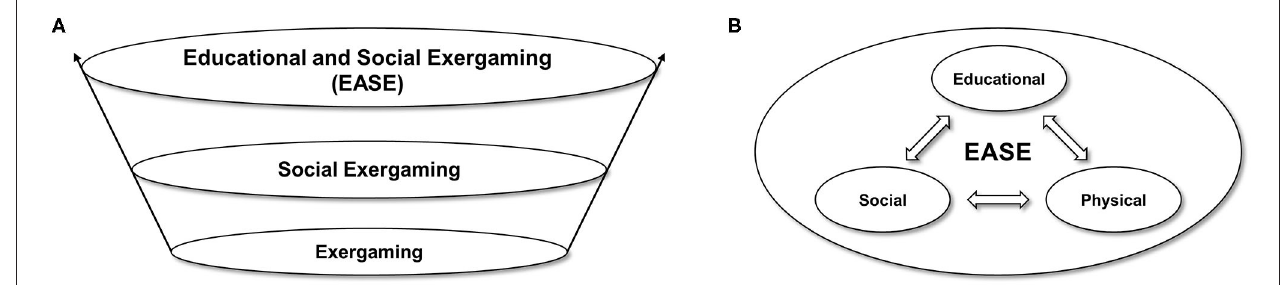
FIGURE 1 | Educational and Social Exergaming (EASE). (A) The pure physical dimension, which is addressed by exergaming by definition, is supplemented by the social dimension of social exergaming and by an educational dimension, forming three levels. The highest level is represented by EASE. However, the vertical transitions between the model’s levels are fluid rather than categorical. (B) The physical, social, and educational dimensions of EASE are strongly